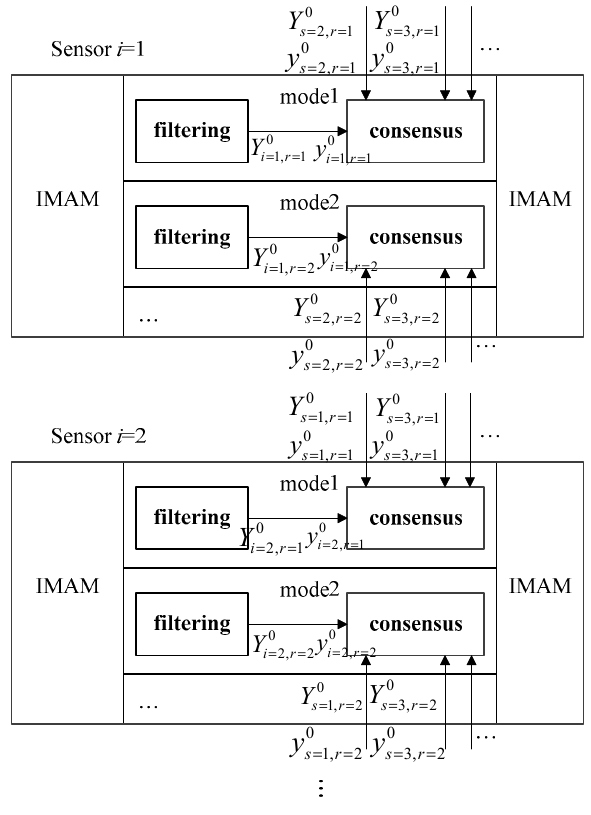
Figure 2. Structure of Interacting Multiple Adaptive Model-Unscented Information Consensus Filter.